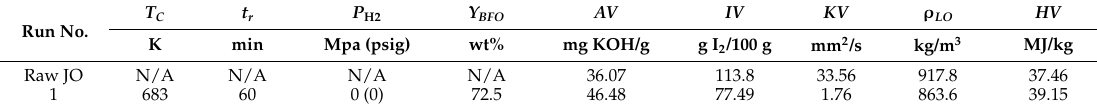
Table 1. Yield and properties of BFO obtained from thermal cracking of JO at T C = 683 K. Y BFO : yield of jatropha oil (JO) derived bio-fuel oil (BFO); T C : setting temperature; t r : retention time; P H2 : H 2 pressure; IV : iodine value; KV: kinematic viscosity; ρ LO ; density; HV : heating value; and N/A: not